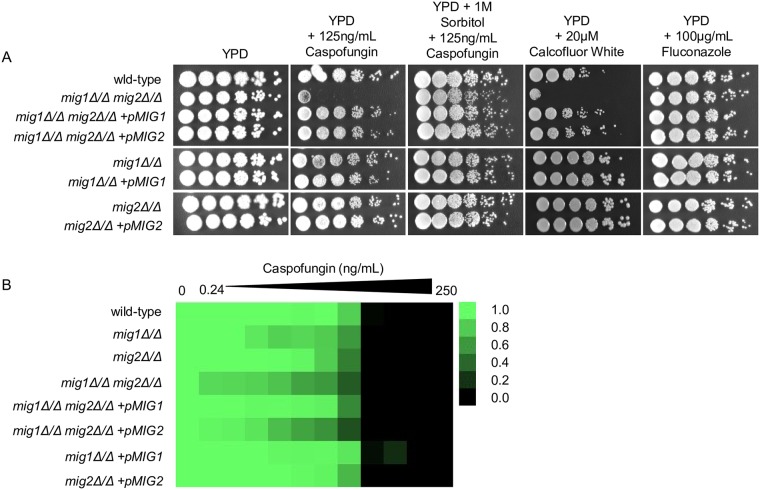
Growth of Mig1/2 mutant and complemented strains during cell wall stress.A. Plate dilution sensitivity assay. Tenfold serial dilutions of the indicated strains were spotted on YPD and YPD with 100 ng/mL Caspofungin, 100 ng/mL Caspofungin and 1 M Sorbitol, 20 μM Calcofluor White, and 100 μg/mL Fluconazole. Growth was visualized after 48 hours of incubation at 37°C. B. Quantitative caspofungin sensitivity assay in 96 well plates. Cells were incubated in liquid YPD media at 37°C containing 2-fold dilutions of Caspofungin. Absorbance was read at 600nm after 48 hours of incubation. Data was averaged from three biological replicates of duplicate measurements and normalized to cell growth without antifungal.